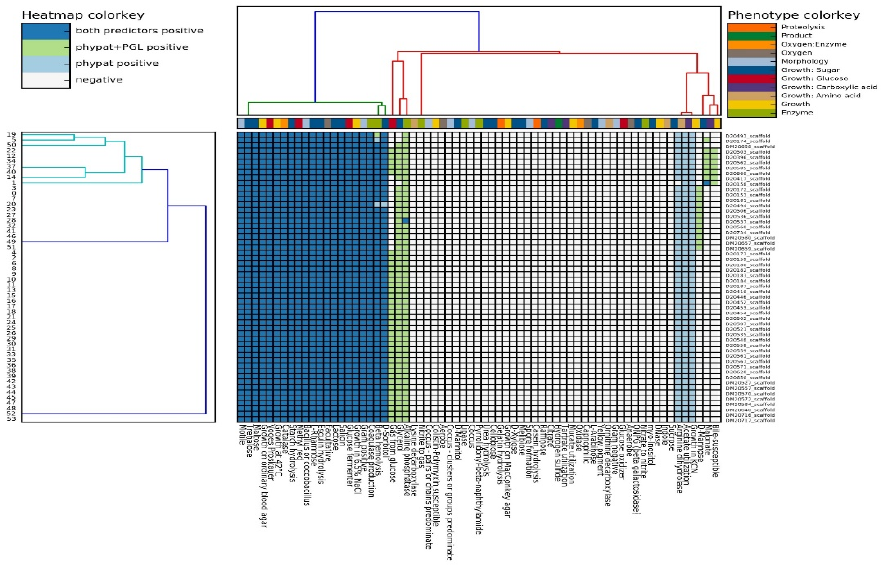
Figure 1. Phenotyping of L. monocytogenes with Traitar. Heatmap of phenotypic characteristics for the pathogen’s strains isolated from Myzithra soft whey cheese and related food processing surfaces. Key phenotypic characteristics for L. monocytogenes identification are grouped on the left side of the heatmap (dark blue entries). The color of the heatmap entries is determined by the origin of the phenotype’s prediction (Traitar phypat and/or phypat + PGL classifier). The colors of the dendrogram indicate similar phenotype distributions across strains, as determined by hierarchical clustering with SciPy (http://docs.scipy.org/doc/scipy/reference/cluster.hierarchy.html, accessed on 6 February 2023).